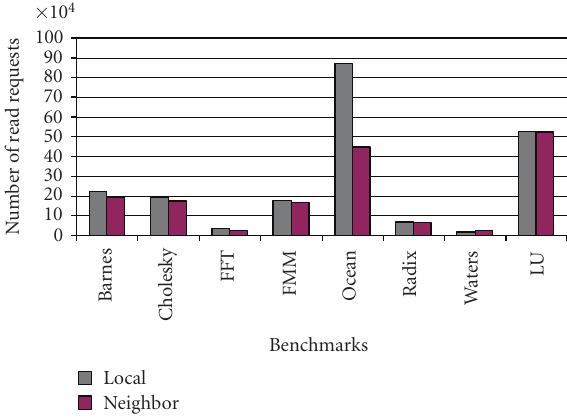
Figure 17: Profiling results for read requests.